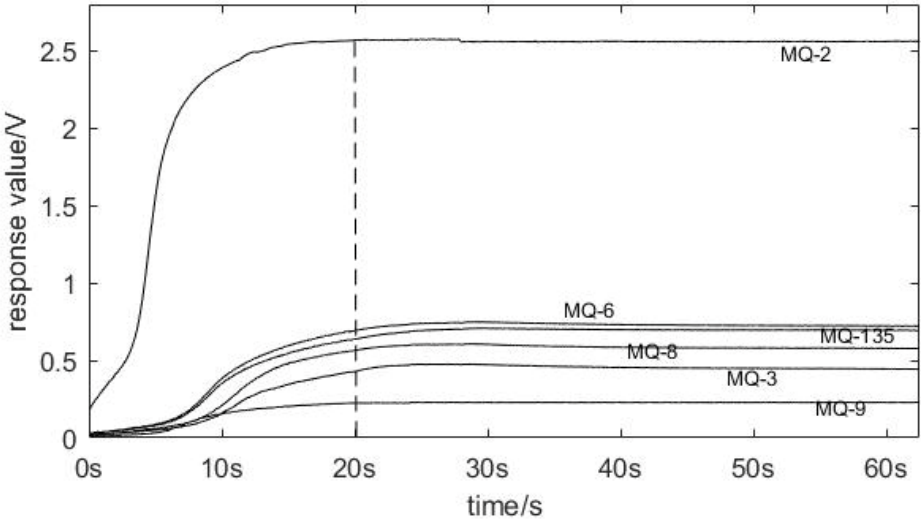
Figure 8. Comparison of data collection before and after optimization design.